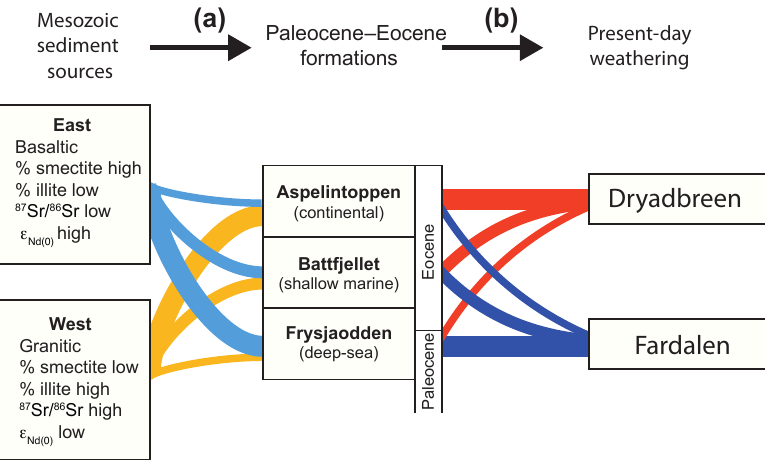
Figure 10. Summary of the processes leading to the variation in clay mineralogy, 87 Sr / 86 Sr and ε Nd observed in the two studied catchments. The thickness of the lines gives an indication of the relative contribution of Mesozoic sources to Eocene formations and the Eocene formations to suspended sediment export from the two catchments. For example, the Frysjaodden Formation receives a greater proportion of sediment from the eastern source as compared to the western source. (a) The contribution of Mesozoic sediment sources to Eocene formations is determined by the depositional location (far-shore vs. near-shore), particle size and susceptibility to authigenic phase formation. (b) The contribution of the Paleogene formations to the present-day suspended sediment load is determined by the present-day exposure of the formations in each catchment (Fig. 2) which is determined by the recent erosional history of the